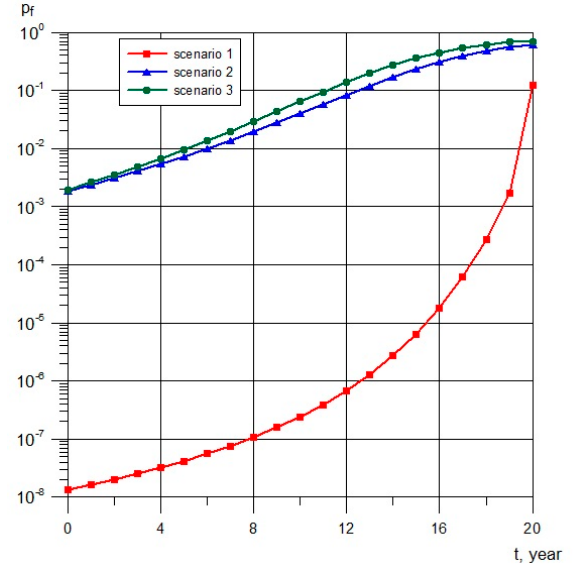
Figure 8. Change in the probability of rotor failure for different operating scenarios ( 𝑎 (cid:2868) = 5 mm).